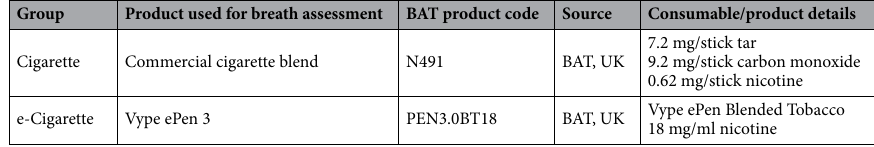
Table 1. Products assessed.